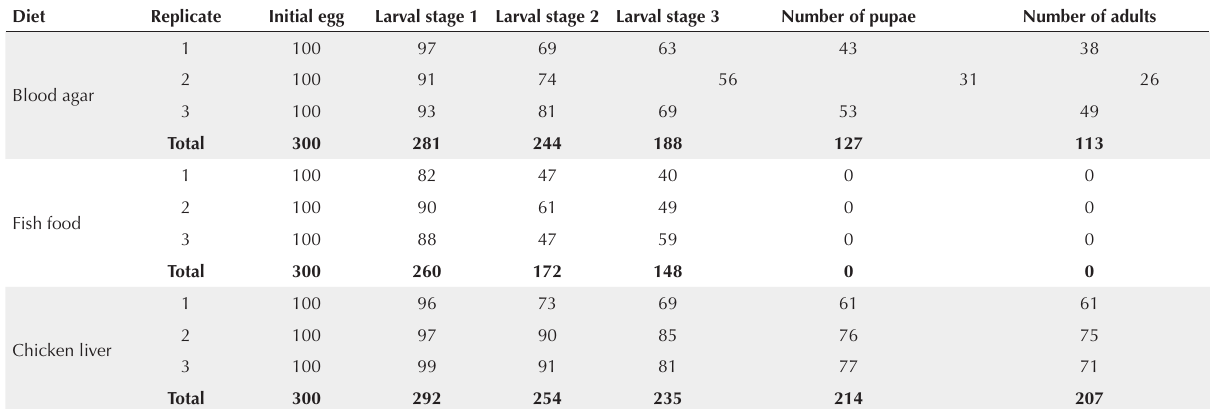
Table 3. The Number of Living Larvae at Different Growth Stages of L. sericata